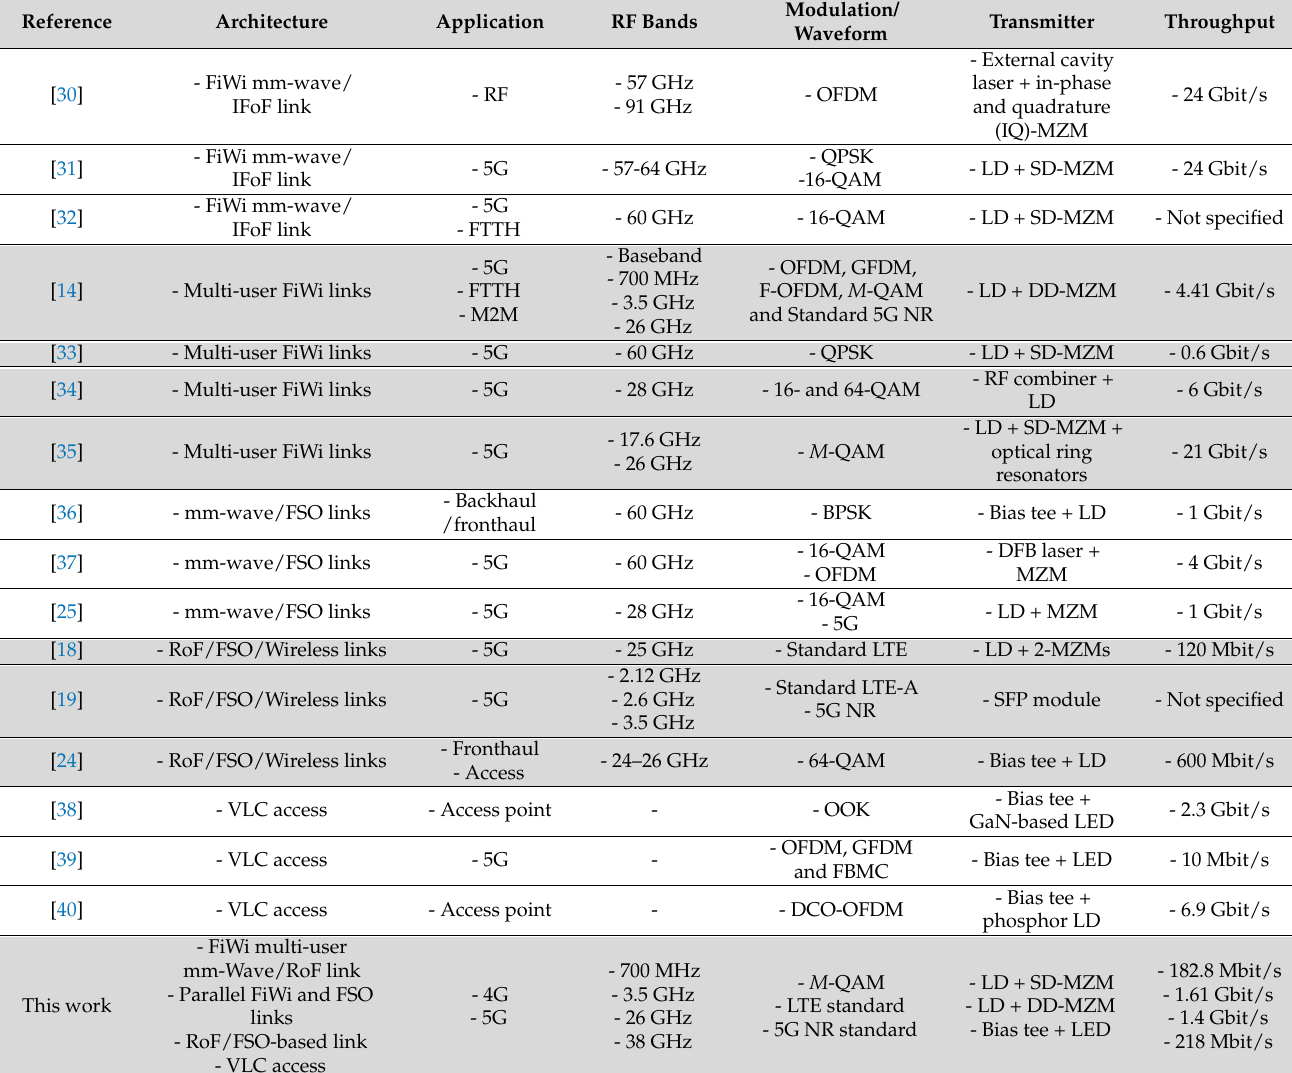
Table 1. State of the art on optical-wireless techniques for 5G radio access